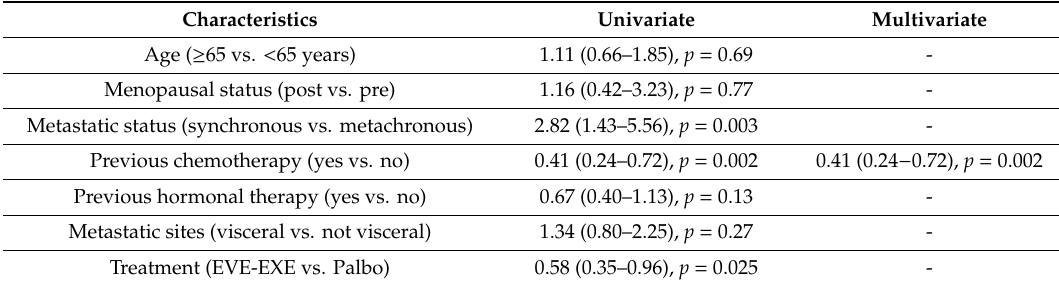
Figure 1. Progression-free survival (PFS). N: number; EVE: everolimus; EXE: exemestane; PALBO: palbociclib; FULV: fulvestrant. Table 2. Univariate and multivariate analysis for progression-free survival